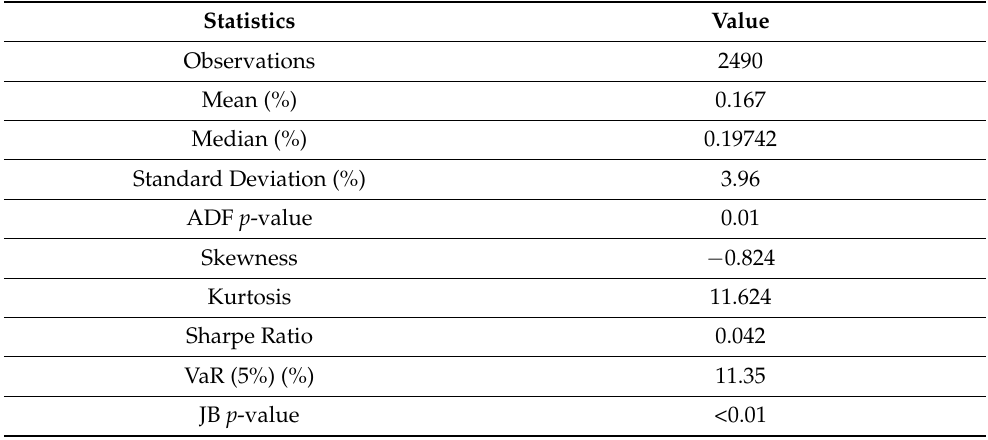
Table 7. Descriptive Statistics and stationarity test for Bitcoin.